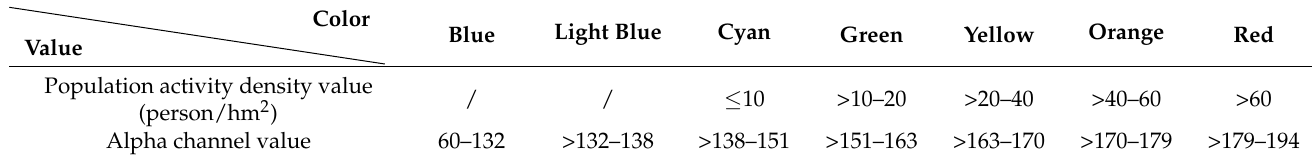
Table 5. Correspondence between population density and alpha channel